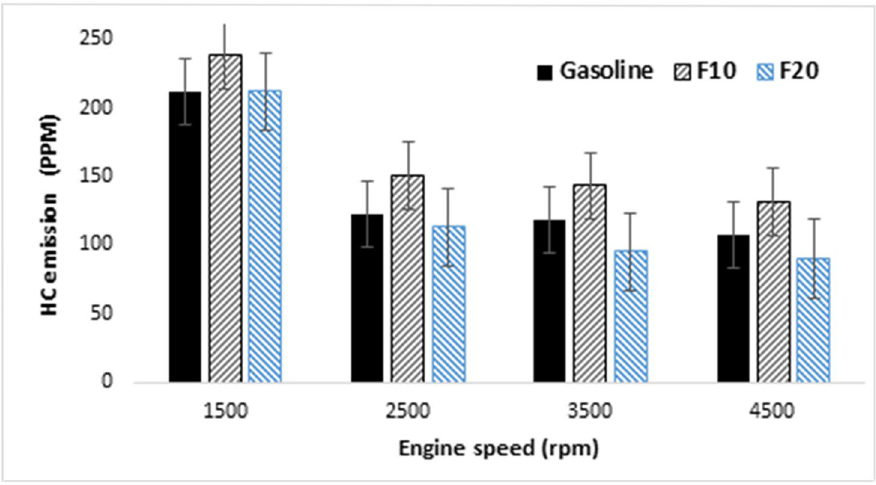
Figure 12. HC emissions variation with increasing engine